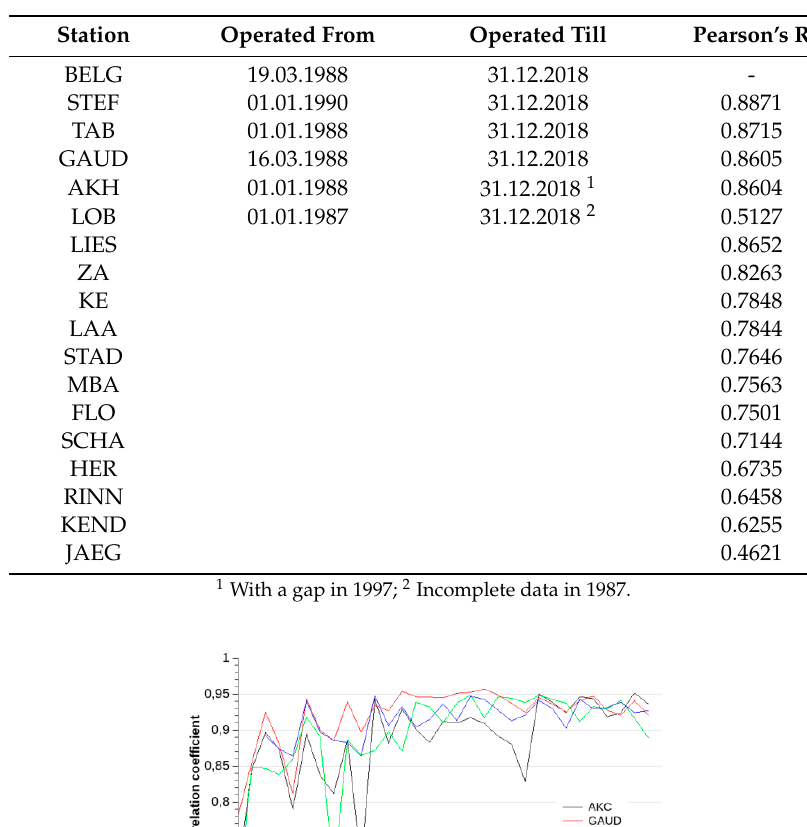
Table 1. Air quality stations and correlation for daily NO 2 with Belgradplatz (BELG).